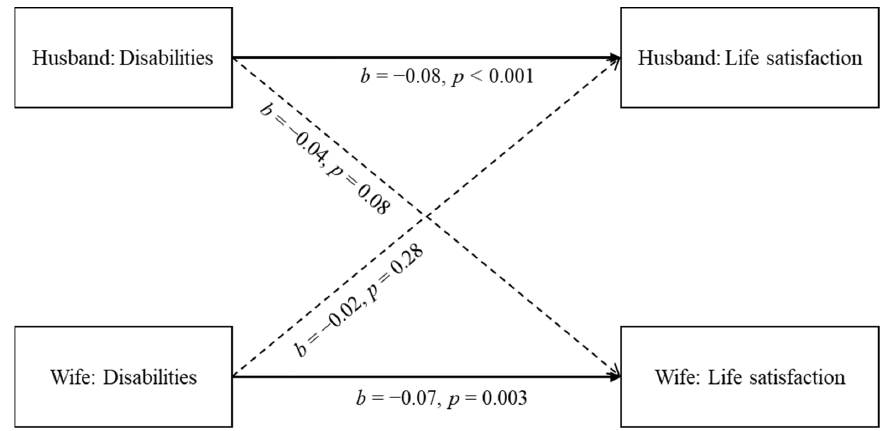
Figure 1. The results of APIM for the dyadic effect of overall disabilities on life satisfaction. Table 1. The results of APIM for the dyadic effect of overall disabilities on life satisfaction. For the gender effect, the mixed linear model analysis indicated that the actor effect (i.e., the association between one’s disabilities and life satisfaction), b = − 0.001, p = 0.97, 95% CI = ( − 0.03, 0.03), and the partner effect (i.e., the association between spousal disabilities and one’s life satisfaction), b = 0.01, p = 0.59, 95% CI = ( − 0.02, 0.04), were not significantly moderated by